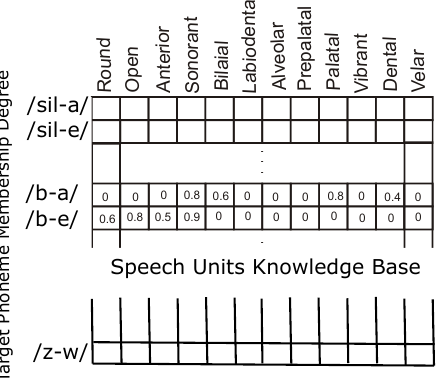
Figure 5. Basic speech units knowledge